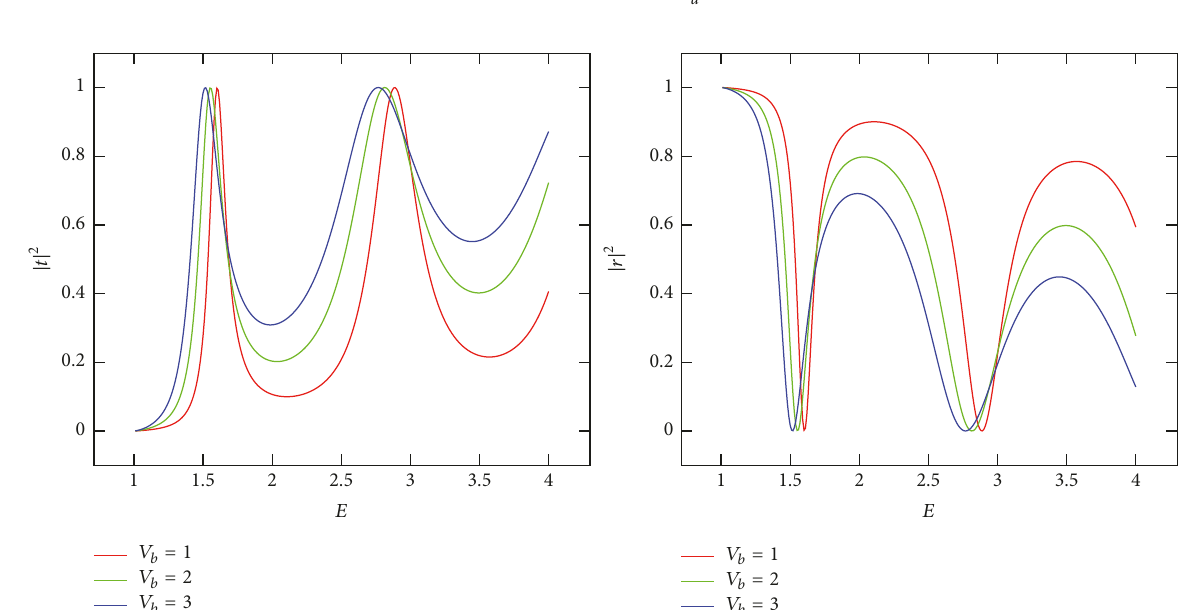
Figure 2: Effects of different values of 𝑉 푎 on the coefficients.